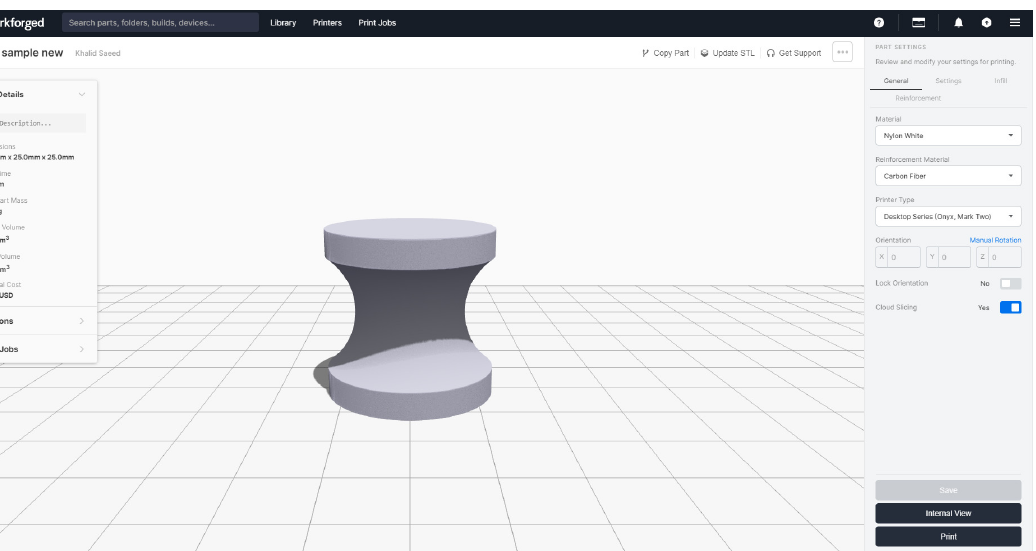
Figure 1. Sample design and the amount of polymer and fibre calculated by the slicing software (Eiger).